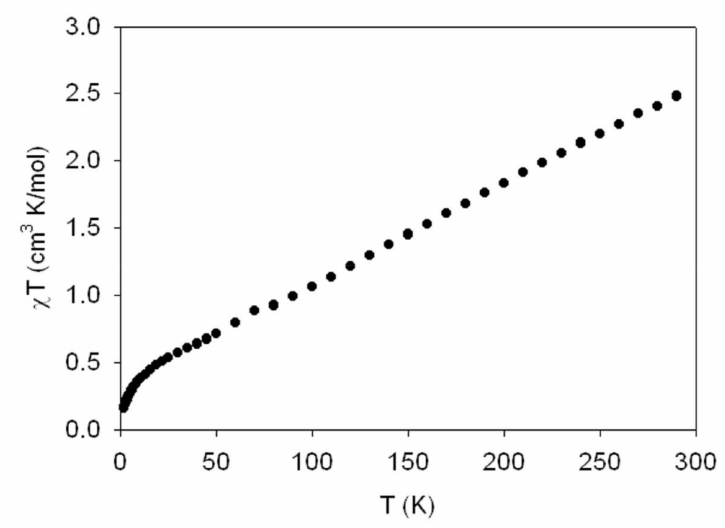
Figure 6. χ T vs. T plot for SYML1-Fe measured with an applied dc field of 0.5